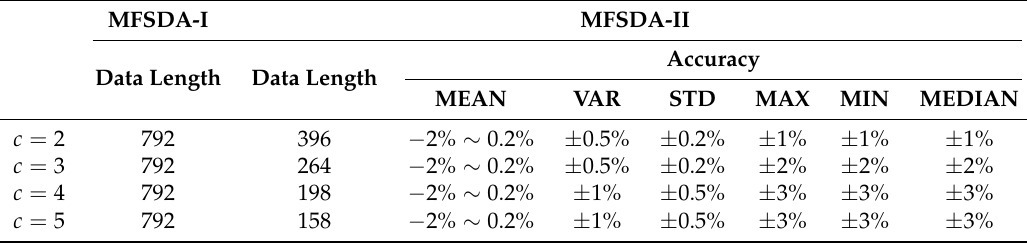
Table 8. Comparison between MFSDA-I and RCDA based on Wind Direction of TAO Project (units: